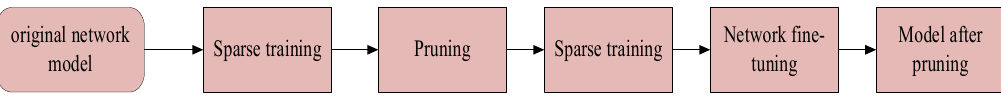
Figure 4. Flow chart of model pruning.